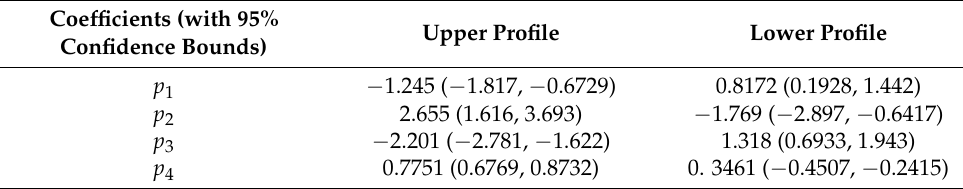
Table 1. Fourth-order constant-free polynomial coefficient